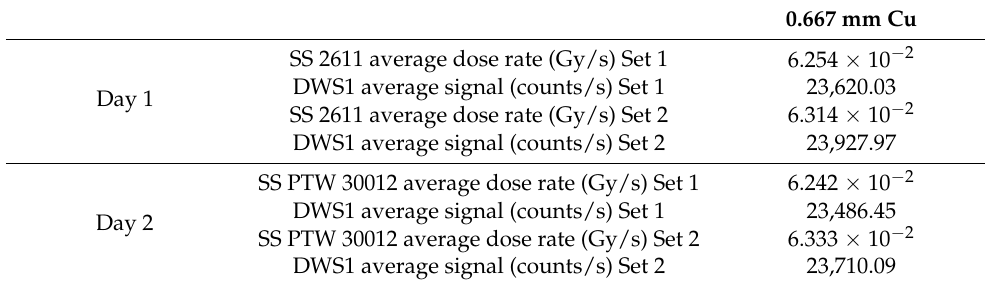
Table 4. Measurements recorded during the DWS1 cross-calibration at UCL’s SARRP facility.